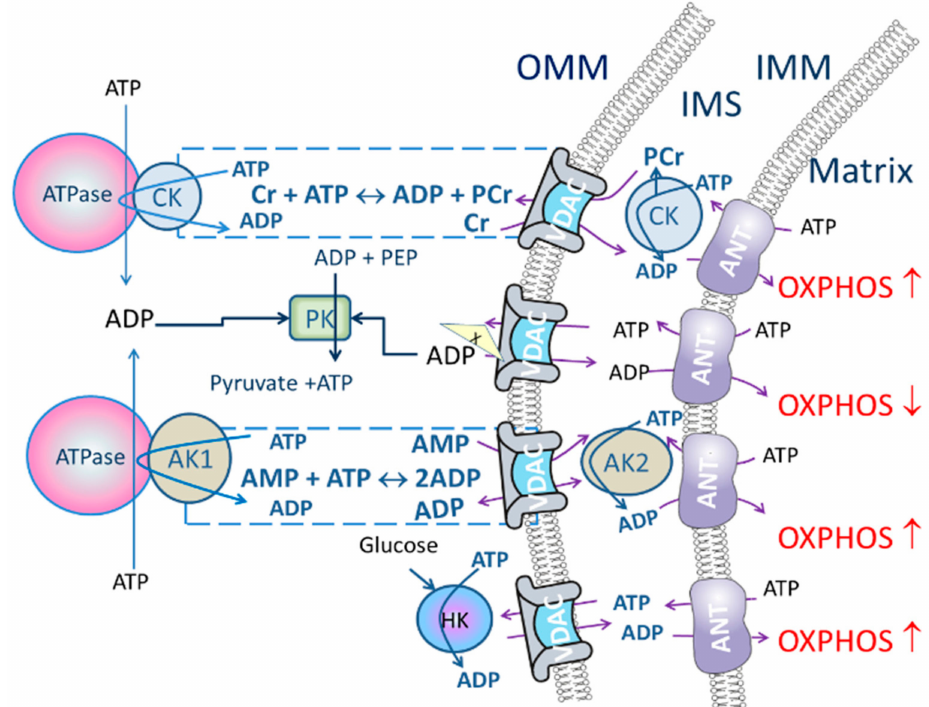
Figure 1. Cellular energy fluxes and transport routes in the context of the current review. In permeabilized cells cytosolic water-soluble liquid components and freely floating proteins are washed out but most of the ATPases and enzymes attached to cytoskeleton or other structures remain active. The movement of the adenine nucleotides through mitochondrial outer membrane (OMM) voltage-dependent anion channel (VDAC) may be restricted by specific protein complex (X). However, the cytosolic creatine kinase (CK) isoforms coupled with ATPase and mitochondrial CK and adenylate kinase (AK) cytosolic isoform AK1 and mitochondrial AK2 create an opportunity for energy transport without ADP and ATP free diffusion in the cytoplasm. In these energy-transfer networks ADP generated in ATPase reactions and ATP produced in mitochondria are quickly directed to CK and AK reactions. Therefore, adding CK and AK activating compounds (creatine (Cr) or AMP, respectively) is also reflected in the rate of oxidative phosphorylation (OXPHOS). In the case of the AK shuttle the AMP derived from AK (AK1) reactions in the cytoplasm enters to the IMS where AK2 converts AMP and ATP to ADP. In addition to speed up the movement of the energy-rich phosphoryl group in cytoplasm, these energy transport systems provide better feedback between ATP consumption and synthesis. Addition of pyruvate kinase (PK) and phosphoenol pyruvate (PEP) to medium traps ADP that is not attached to energy transport systems. Therefore, in the presence of PK-PEP system and without activation of the CK or AK pathway the rate of OXPHOS decreases. Hexokinase (HK) bound to VDAC directs mitochondrial ATP to glycolysis pathway and remained ADP can stimulate OXPHOS. Adenine nucleotide translocase (ANT) is situated in the inner mitochondrial membrane (IMM). IMS, mitochondrial intermembrane